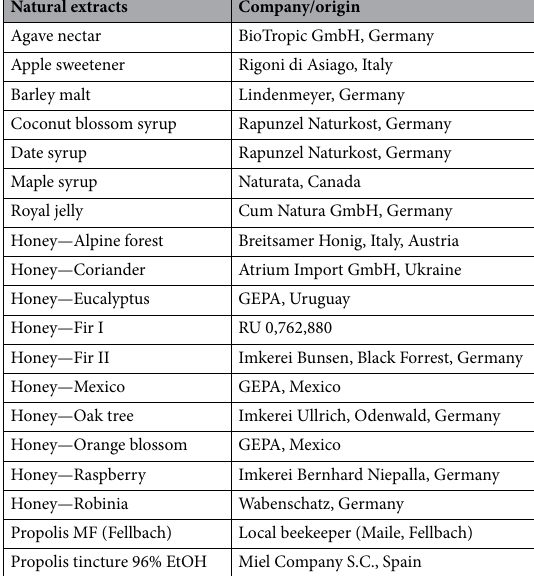
Table 1. Description of natural extracts, honey, and propolis